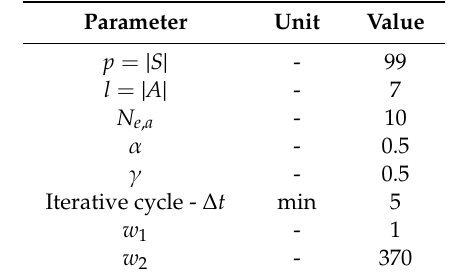
Table 5. Parameters of the Q-learning algorithm used to produce the data (where not otherwise